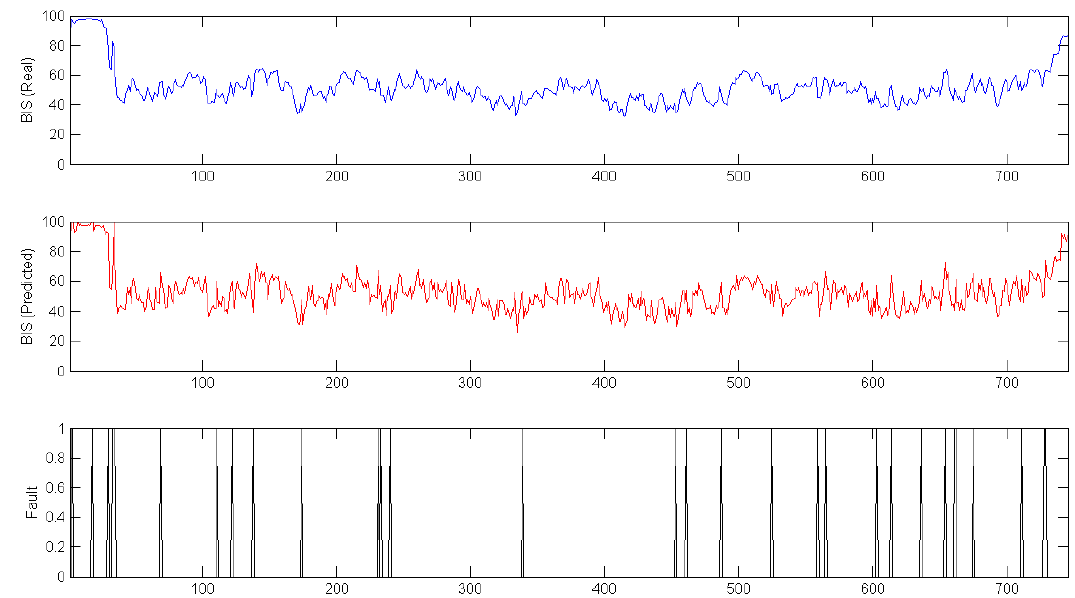
Figure 8. Real ( Top ); Predicted ( Middle ); and Fault ( Bottom ) Complete surgery with fault detection Range of